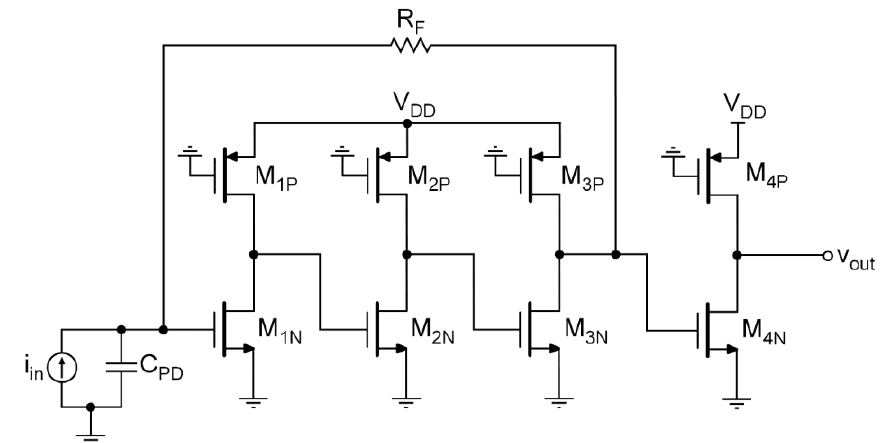
Figure 3. Transistor-level topology of the transimpedance amplifier employed in the simulations to test the proposed noise-reduction technique.